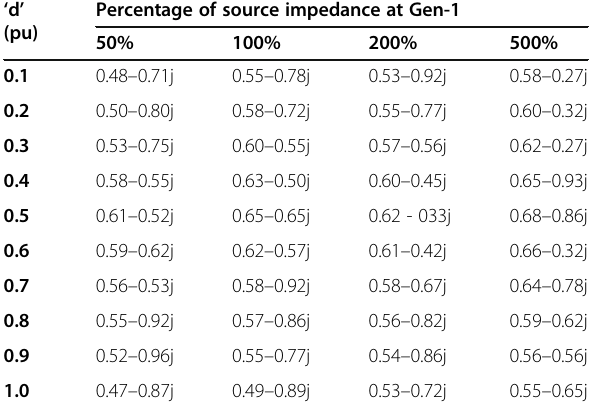
Table 3 Effect of variations in source impedance ‘ d ’